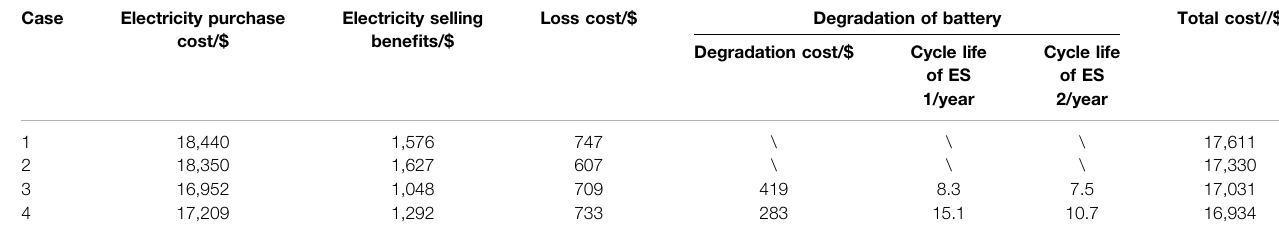
TABLE 1 | Optimization